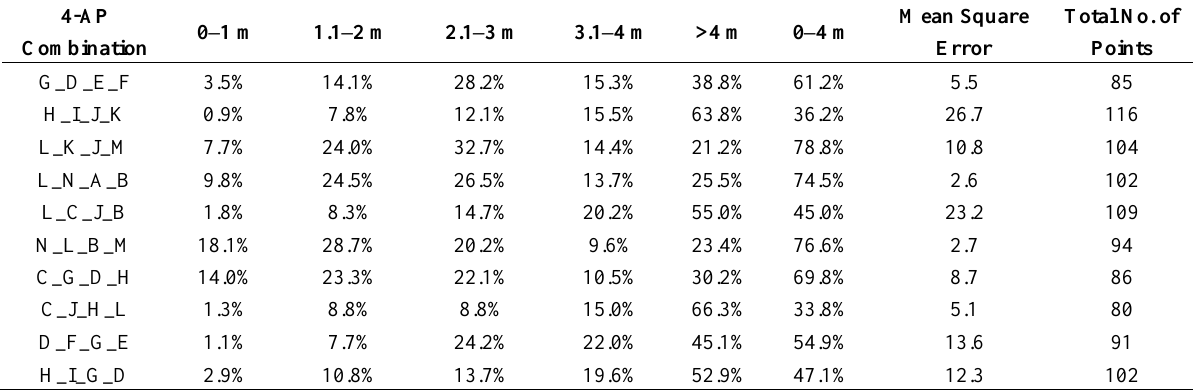
Table 1. Accuracy achievement based on signal reception of four access points